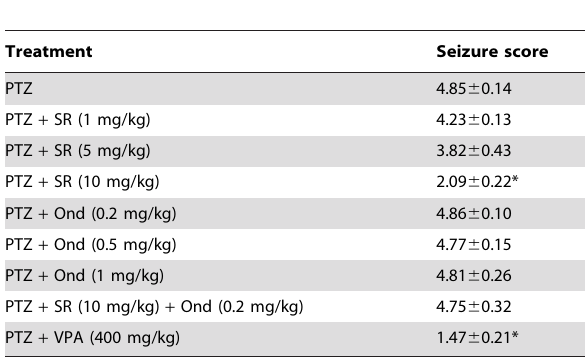
Table 2. Effects of SR 57227 and ondansetron on PTZ- induced mortality in